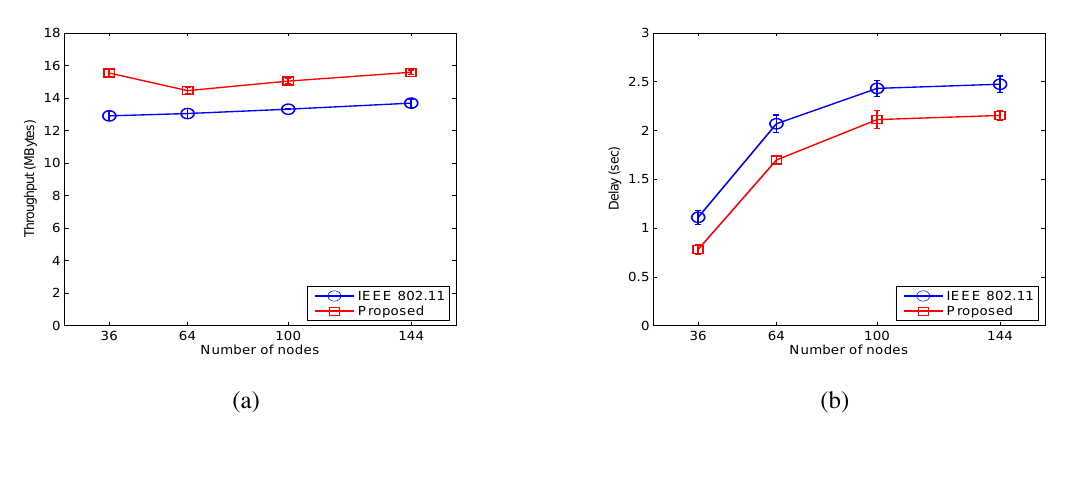
= 4 dB. (a) Throughput. dB